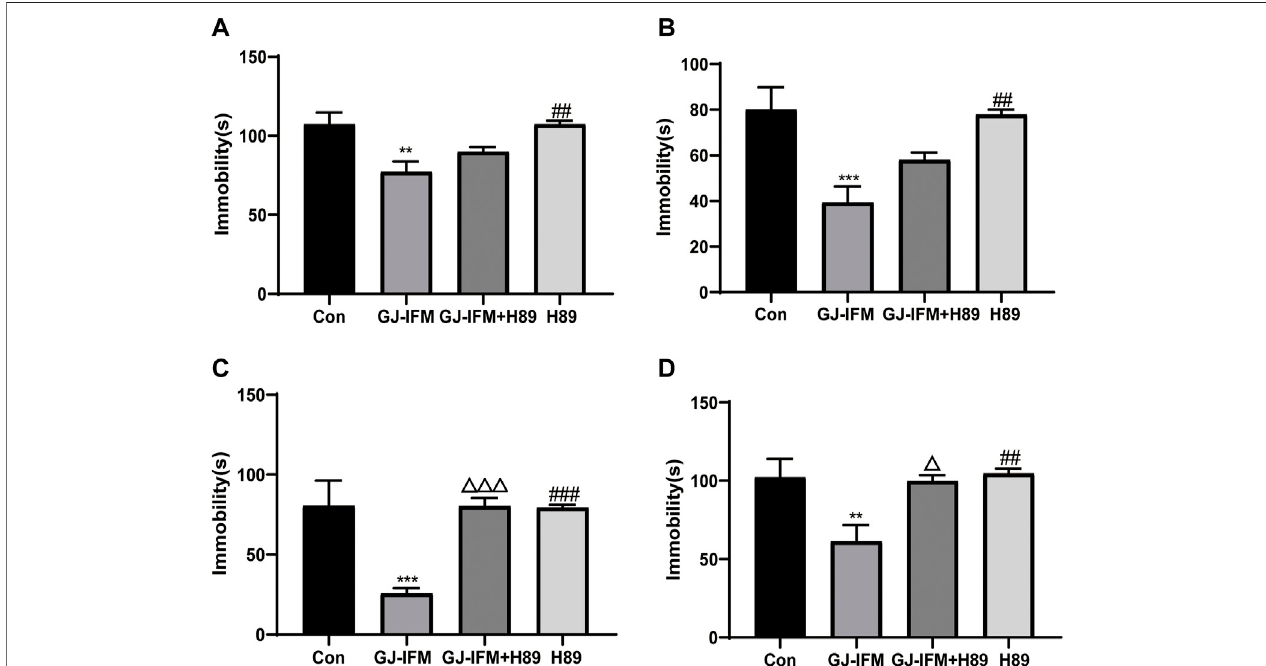
FIGURE 11 | The effects of PKA antagonist H89 on the antidepressant response after a single GJ-IFM treatment. (A) The effect of H89 pretreatment on immobility time in TST 30 min after GJ-IFM treatment in KM mice. One-way ANOVA, p > 0.05, GJ-IFM vs . GJ-IFM + H89. (B) The effect of H89 pretreatment on immobility time in TST2 hafterGJ-IFMtreatmentinKMmice.One-wayANOVA, p > 0.05,GJ-IFM vs .GJ-IFM+H89. (C) TheeffectofH89pretreatmentonimmobilitytimeinTST1 dafter GJ-IFM treatment in KM mice. One-way ANOVA, △△△ p < 0.001, GJ-IFM vs . GJ-IFM + H89. (D) The effect of H89 pretreatment on immobility time in FST at 26 h after GJ-IFM treatment in KM mice. One-way ANOVA, △ p < 0.05, GJ-IFM vs . GJ-IFM +